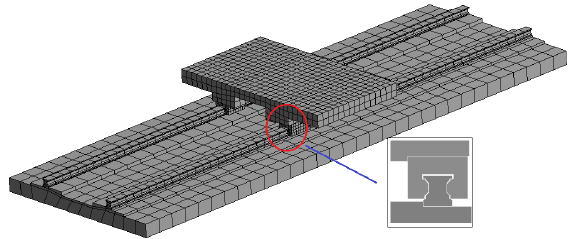
Figure 6. Finite element model of the stage with simplified linear guide.